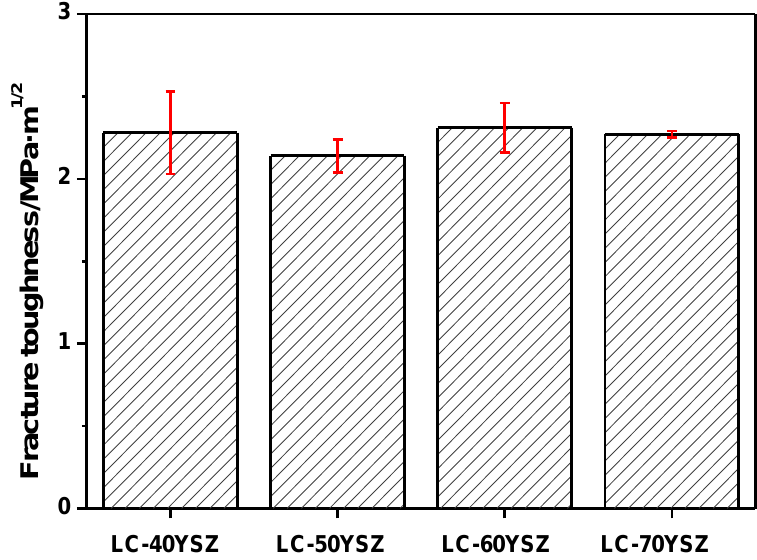
Figure 7. The fracture toughness of LC-YSZ composites.